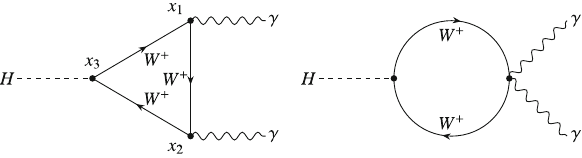
Fig. 1 Diagrams contributing to the amplitude to be